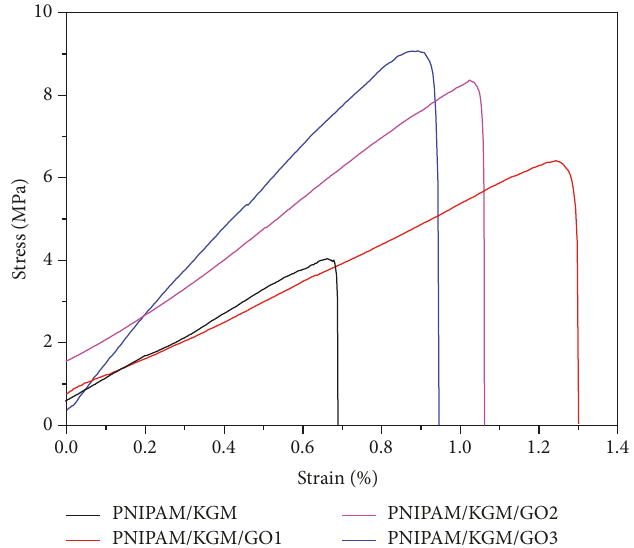
Figure 6: Stress-strain curves of PNIPAM/KGM, PNIPAM/KGM/GO1, PNIPAM/KGM/GO2, and PNIPAM/KGM/GO3 composite